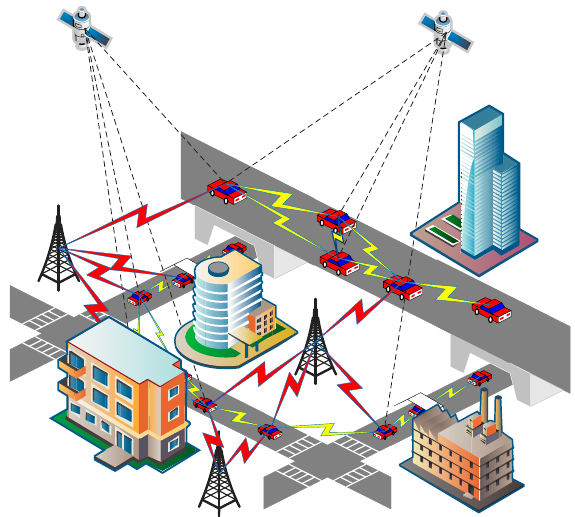
Figure 1. Diagram of multivehicle 3D cooperative positioning scene.